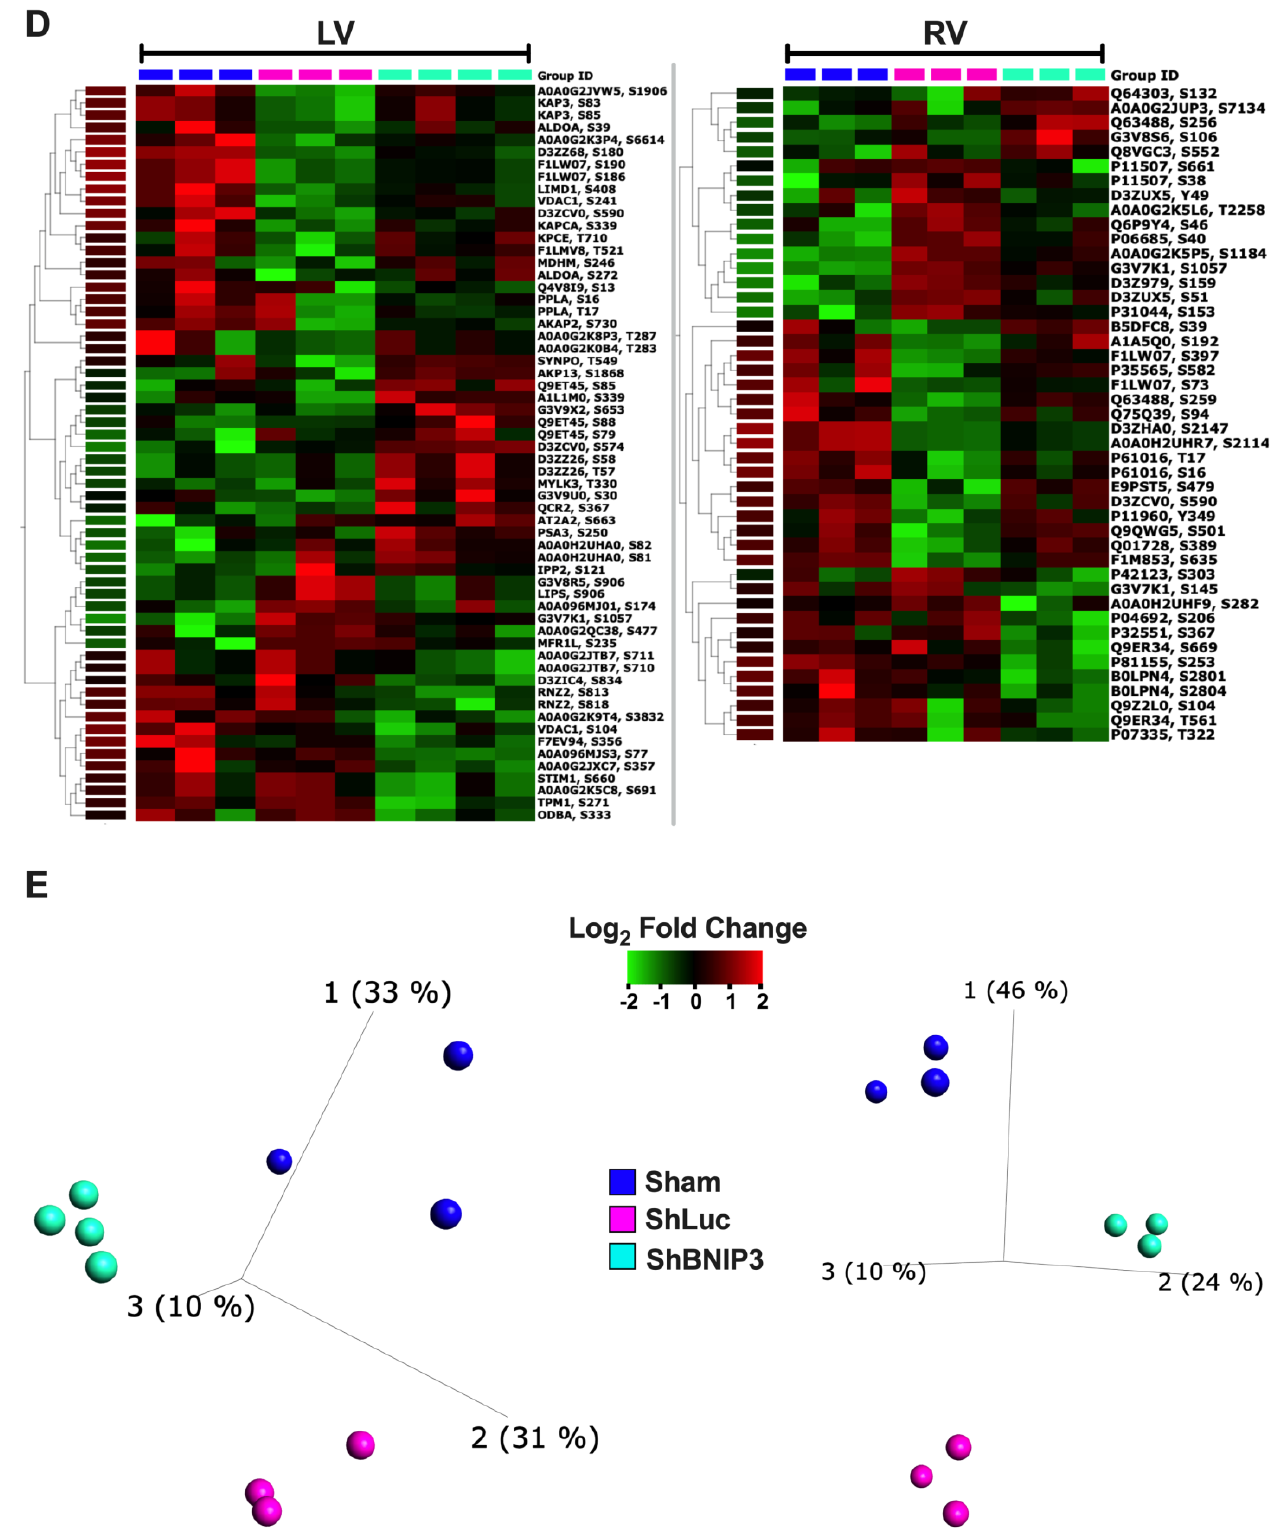
Figure 5. Visualization of the differentially expressed phosphosites in ShBNIP3 vs. ShLuc groups in the LV and RV myocardium p-proteomic datasets. ( A , B ). Heat maps and PCA plots show the relative log 2 -fold expression and the variance in biological samples, respectively, in Sham, ShLuc, and ShBNIP3 groups of the differentially expressed p-sites in ShBNIP3 vs. ShLuc groups in LV (left) and in RV (right) shotgun phosphoproteomic dataset© ( C ). Venn diagrams show the number